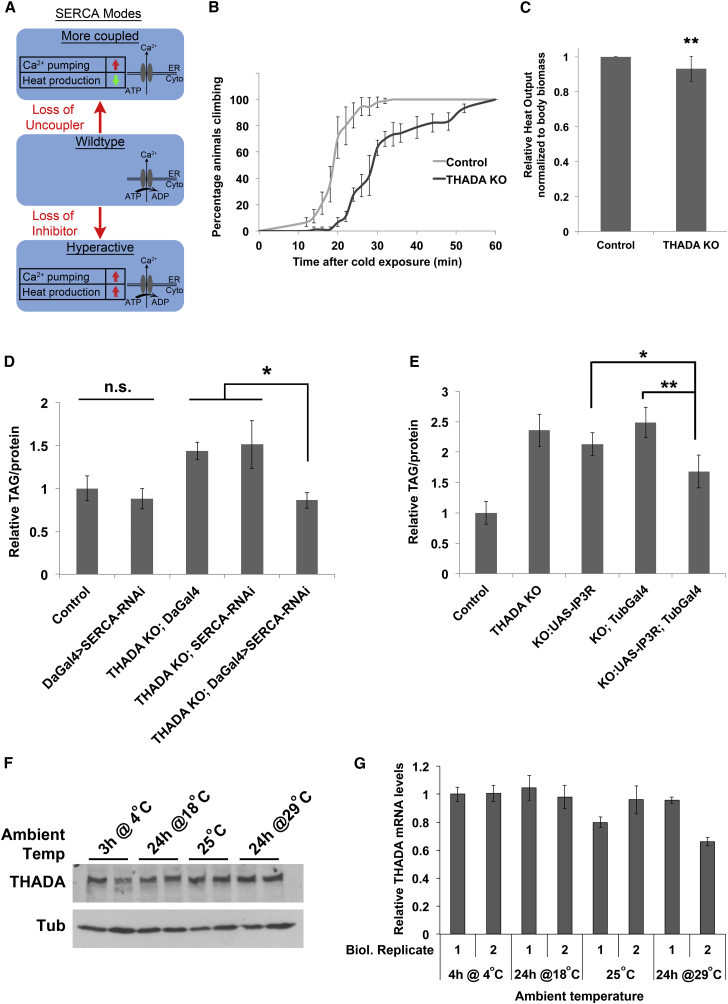
THADA Acts as a SERCA Uncoupling Protein(A) Schematic outlining SERCA activity when it is coupled, uncoupled, or hyperactive.(B) THADAKO flies are hypersensitive to the cold. Adult flies were kept for 3 hr at 4°C to immobilize them. Recovery at room temperature was monitored as the ability to resume climbing (error bars denote SD; n = 3 × 30 adult flies).(C) THADAKO flies generate less heat than control flies. Heat production at 25°C quantified by microcalorimetry, and normalized to total body biomass (fly weight). Error bars denote SD. n = 12 × 5 flies. ∗∗p < 0.01 (t test).(D) Reducing SERCA activity rescues the elevated triglyceride phenotype of THADAKO flies. Relative triglyceride levels in 6-day-old adult females, normalized to total body protein. Mild ubiquitous SERCA knockdown is achieved by combining a weak ubiquitous GAL4 driver (daughterless-GAL4) with an inducible transgene UAS-SERCA-RNAi. Error bars denote SD. ∗p < 0.05; n.s., not significant (p = 0.3) by Student’s t test. n = 3 × 8 adult female flies per genotype.(E) Increasing IP3R activity rescues the elevated triglyceride phenotype of THADAKO flies. Relative triglyceride levels in 6-day-old adult females, normalized to total body protein. Ubiquitous IP3R expression is achieved by combining the ubiquitous Tubulin-GAL4 driver with an inducible transgene UAS-IP3R. Error bars denote SD. ∗p < 0.05, ∗∗p < 0.01 by Student’s t test. n = 3 × 8 adult female flies per genotype.(F and G) THADA protein (F) or mRNA levels (G) do not change strongly upon exposing flies to different temperatures. All conditions were tested in biological duplicates. Adult female flies were shifted to the indicated temperatures for the indicated times prior to lysis for immunoblot or qRT-PCR analysis.